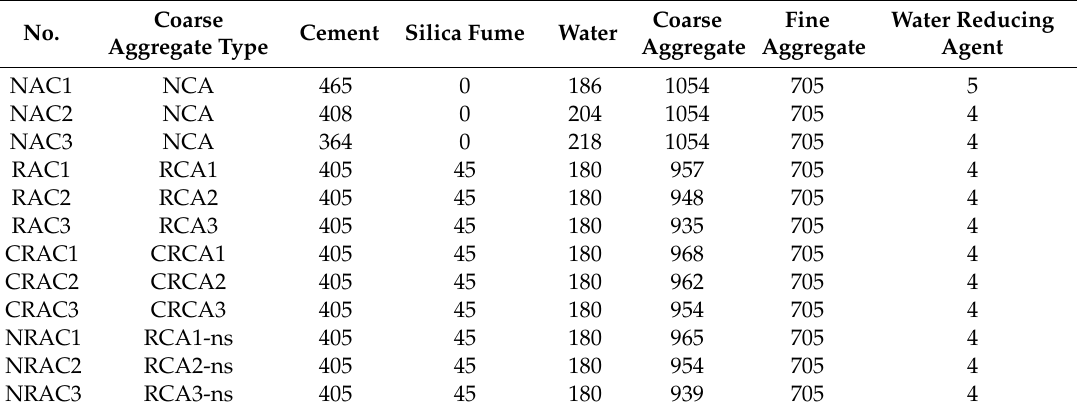
Table 1. Concrete mix proportion (kg / m 3 ).